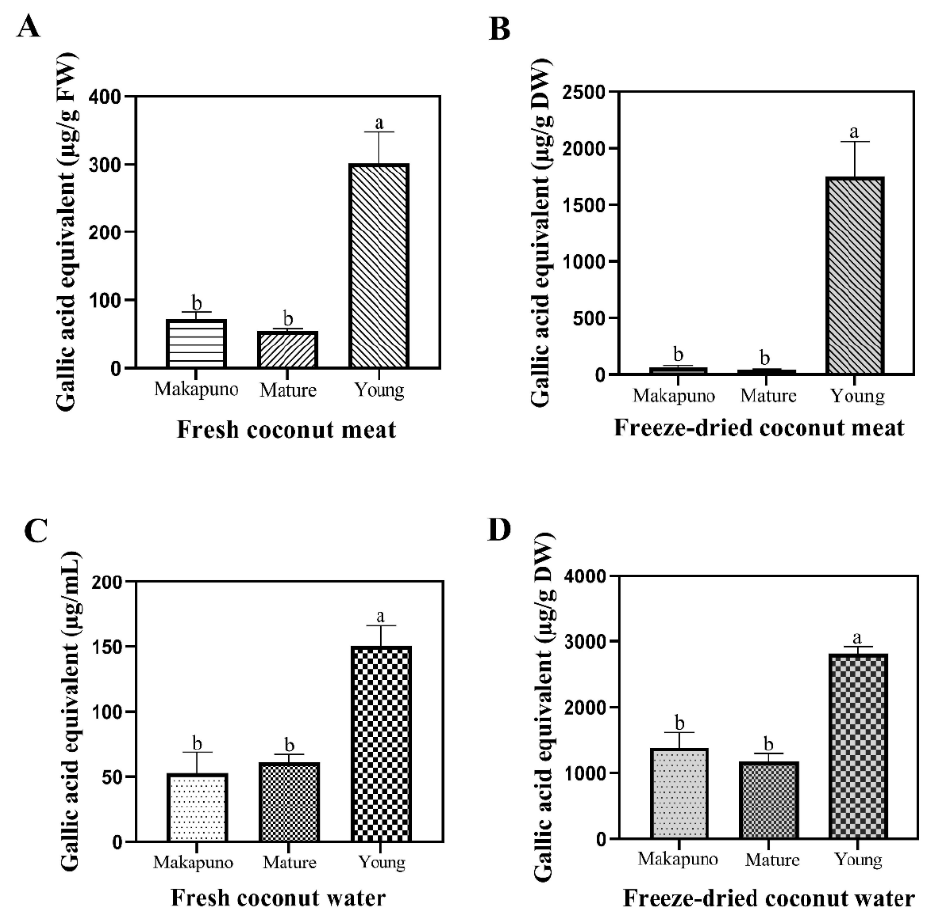
Figure 2. Total phenolic contents of different coconut extracts. ( A ) Fresh coconut meat sample ( B ) Freeze-dried coconut meat sample ( C ) Fresh coconut water sample ( D ) Freeze-dried coconut water sample. All experiments were performed in triplicate. Data are expressed as mean ± SE (n = 3, p < 0.05) for all tested. Different letters indicate mean values significantly different. Flavonoids are secondary metabolites in plants that attract attention due to their antioxidant activity. As shown in Figure 3, total flavonoid content (TFC) was the highest in fresh meat and water of mature coconut (51.84 ± 1.02 µ g/g FW and 11.90 ± 1.81 µ g/mL, respectively) compared to Makapuno and young coconuts (Figure 3A,C). For